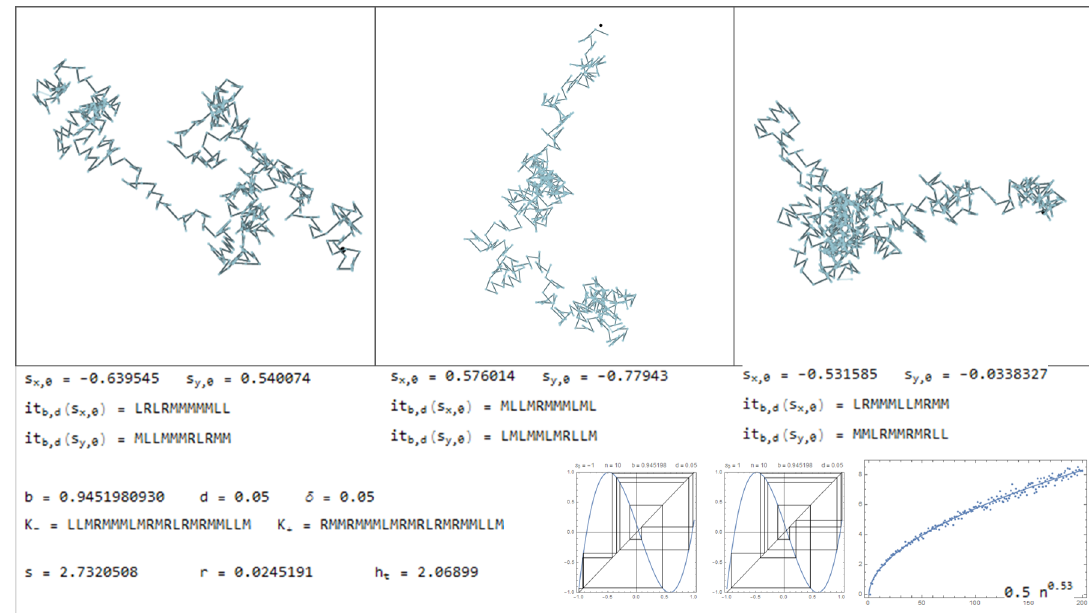
Figure 25. Trajectories produced with b = 0.945198 . . . and d =